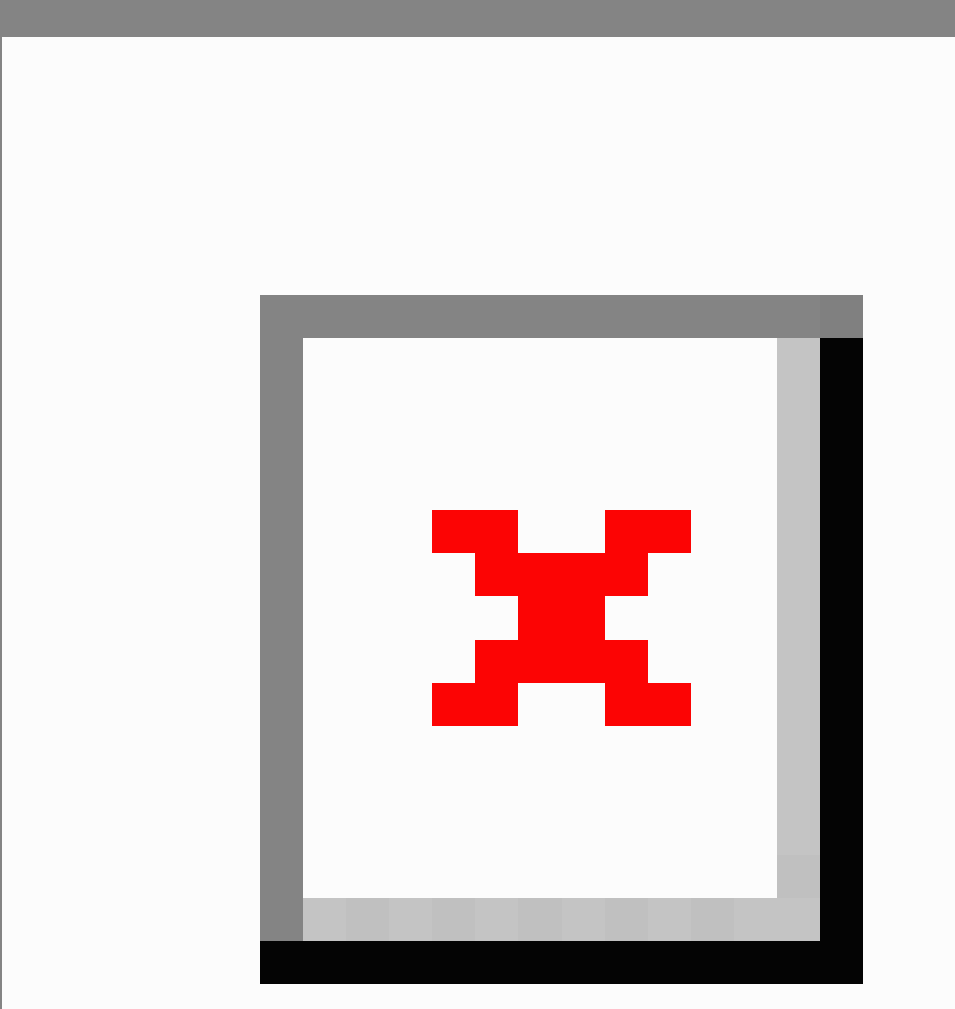
Figure 1. Sponduu: Ability to create event and activity creation